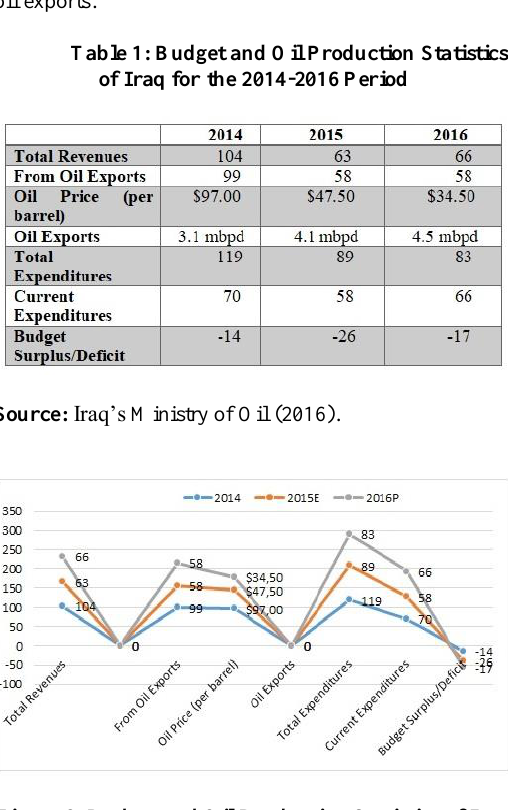
Figure 3. Budget and Oil Production Statistics of Iraq for the 2014-2016 Period Source: Iraq’s Ministry of Oil,